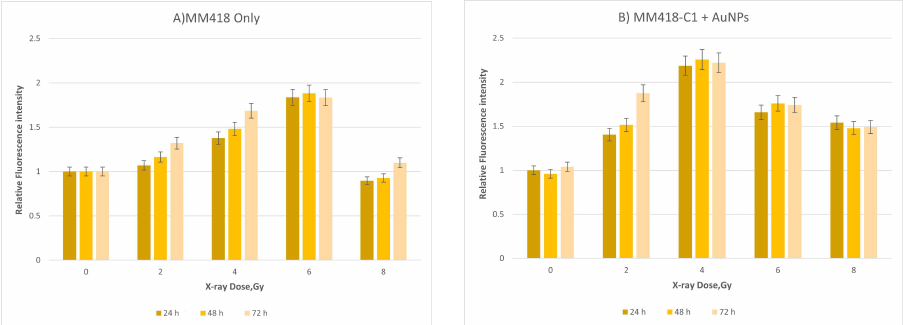
Figure 5. Relative mitochondrial ROS levels in DU145 cells after irradiation ( A ) without AuNPs and ( B ) with AuNPs. Cells were exposed to doses from 0 to 6 Gy. Data are represented as mean values ± SD of three replicate samples.